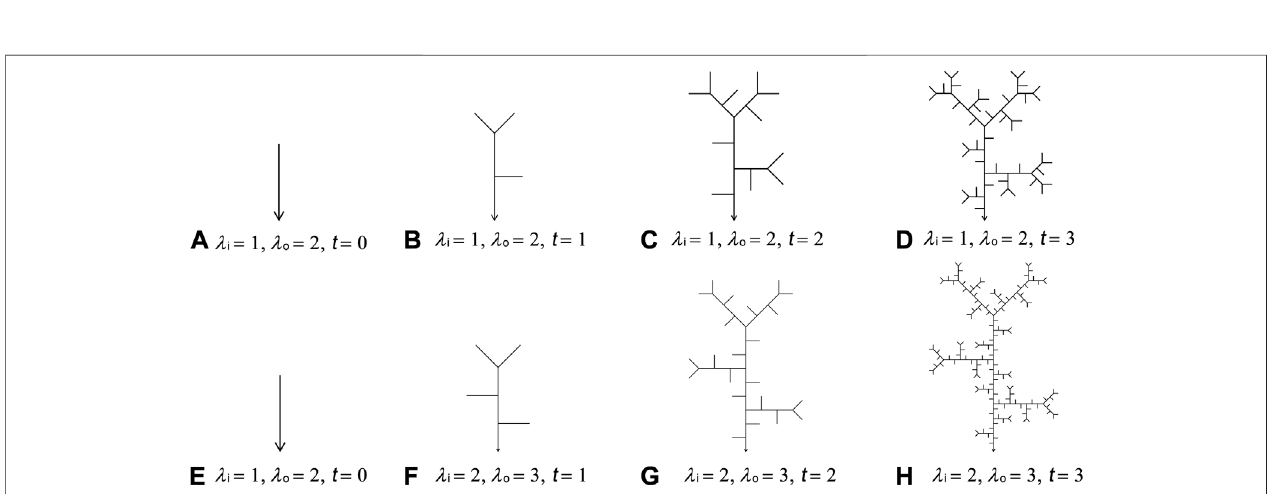
FIGURE4| QU-IBTNs (A) and (E) :initialcases( t (cid:2) 0); (B – D) :generator λ i (cid:2) 1and λ o (cid:2) 2after1,2,and3iterationsteps; (F – H) :generator λ i (cid:2) 2and λ o (cid:2) 3after1,2, and 3 iteration steps.